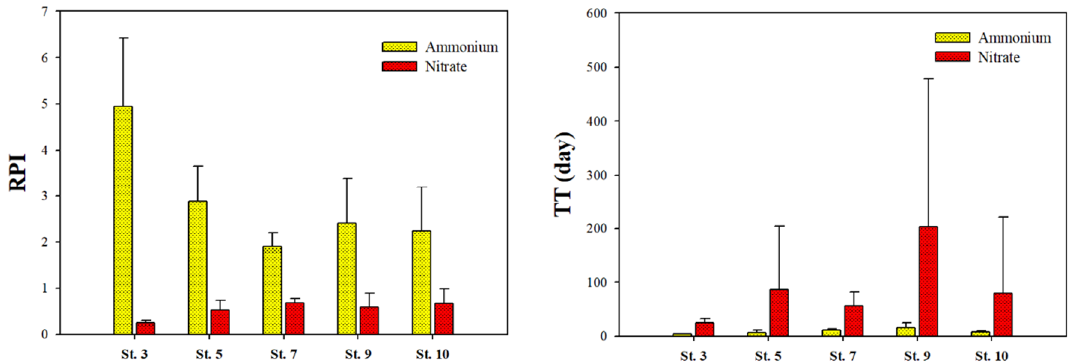
Figure 8. The relative preference index (RPI) and turnover time (TT; day) for picophytoplankton. An RPI > 1 indicates positive nutrient selection for phytoplankton nitrogen uptake.